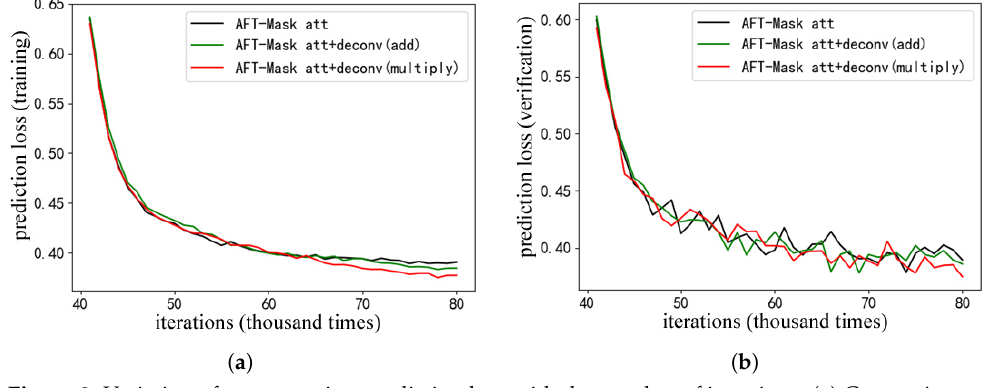
Figure 3. Variation of segmentation prediction loss with the number of iterations. ( a ) Comparison of training losses. ( b ) Comparison of verification